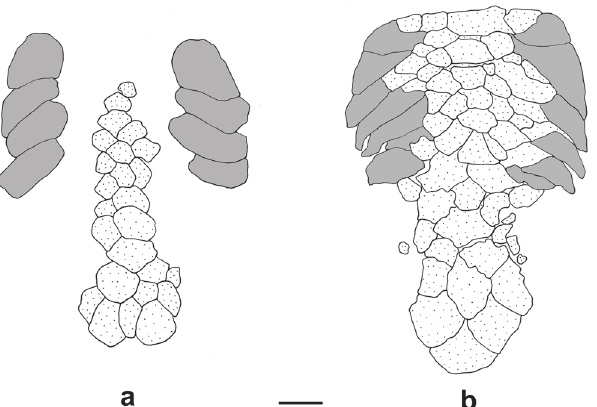
Fig. 5. Dermal plates of abdominal region of Otothyropsis . a. O . piribebuy , MCP 44394, 26.9 mm SL. b. O . marapoama , MCP 42119, 30.8 mm SL. Lateral abdominal plates in gray and central abdominal plates stippled. Scale bar = 1